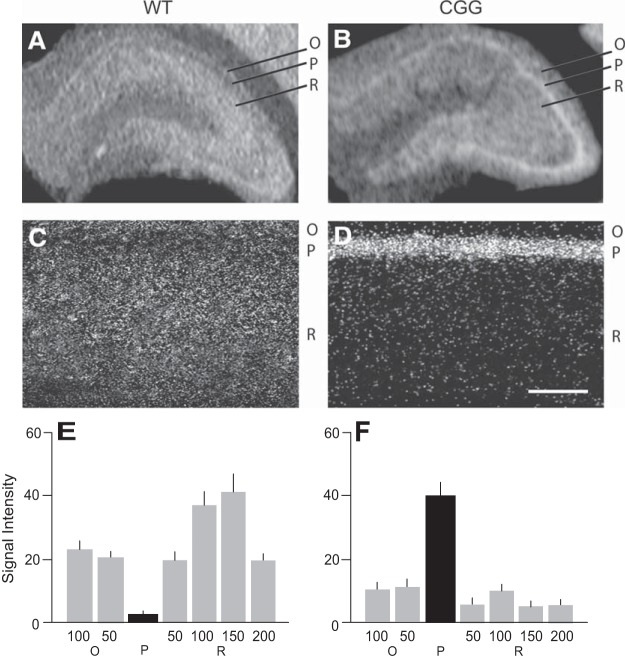
Impaired dendritic localization of BC1 RNA in (CGG)180 animals. CA1 strata oriens (O), pyramidale (P), radiatum (R) are indicated. A, B, Coronal sections through hippocampal regions (film autoradiograms) reveal that BC1 RNA (white signal) is concentrated in CA1 strata oriens and radiatum (i.e., dendritic layers) of WT animals but, in contrast, is concentrated in stratum pyramidale (i.e., cell body layer) of CGG animals. C, D, Emulsion autoradiography of the CA1 hippocampal region confirms predominantly dendritic BC1 labeling (white signal) in WT CA1 but predominantly somatic labeling in CGG CA1. Scale bar for C and D: 100 μm. E, F, Quantitative analysis of emulsion autoradiographs: one-way ANOVA, p < 0.001. Dunnett’s post hoc analysis, comparison of signal intensities (given in relative units) in stratum P (center), in stratum O at distances of 50 and 100 μm from edge of stratum P, and in stratum R at distances of 50, 100, 150, and 200 μm from edge of stratum P, between WT and CGG animals: p < 0.001 for all sample points. n = 4 for WT and CGG animals. Error bars indicate SEM.